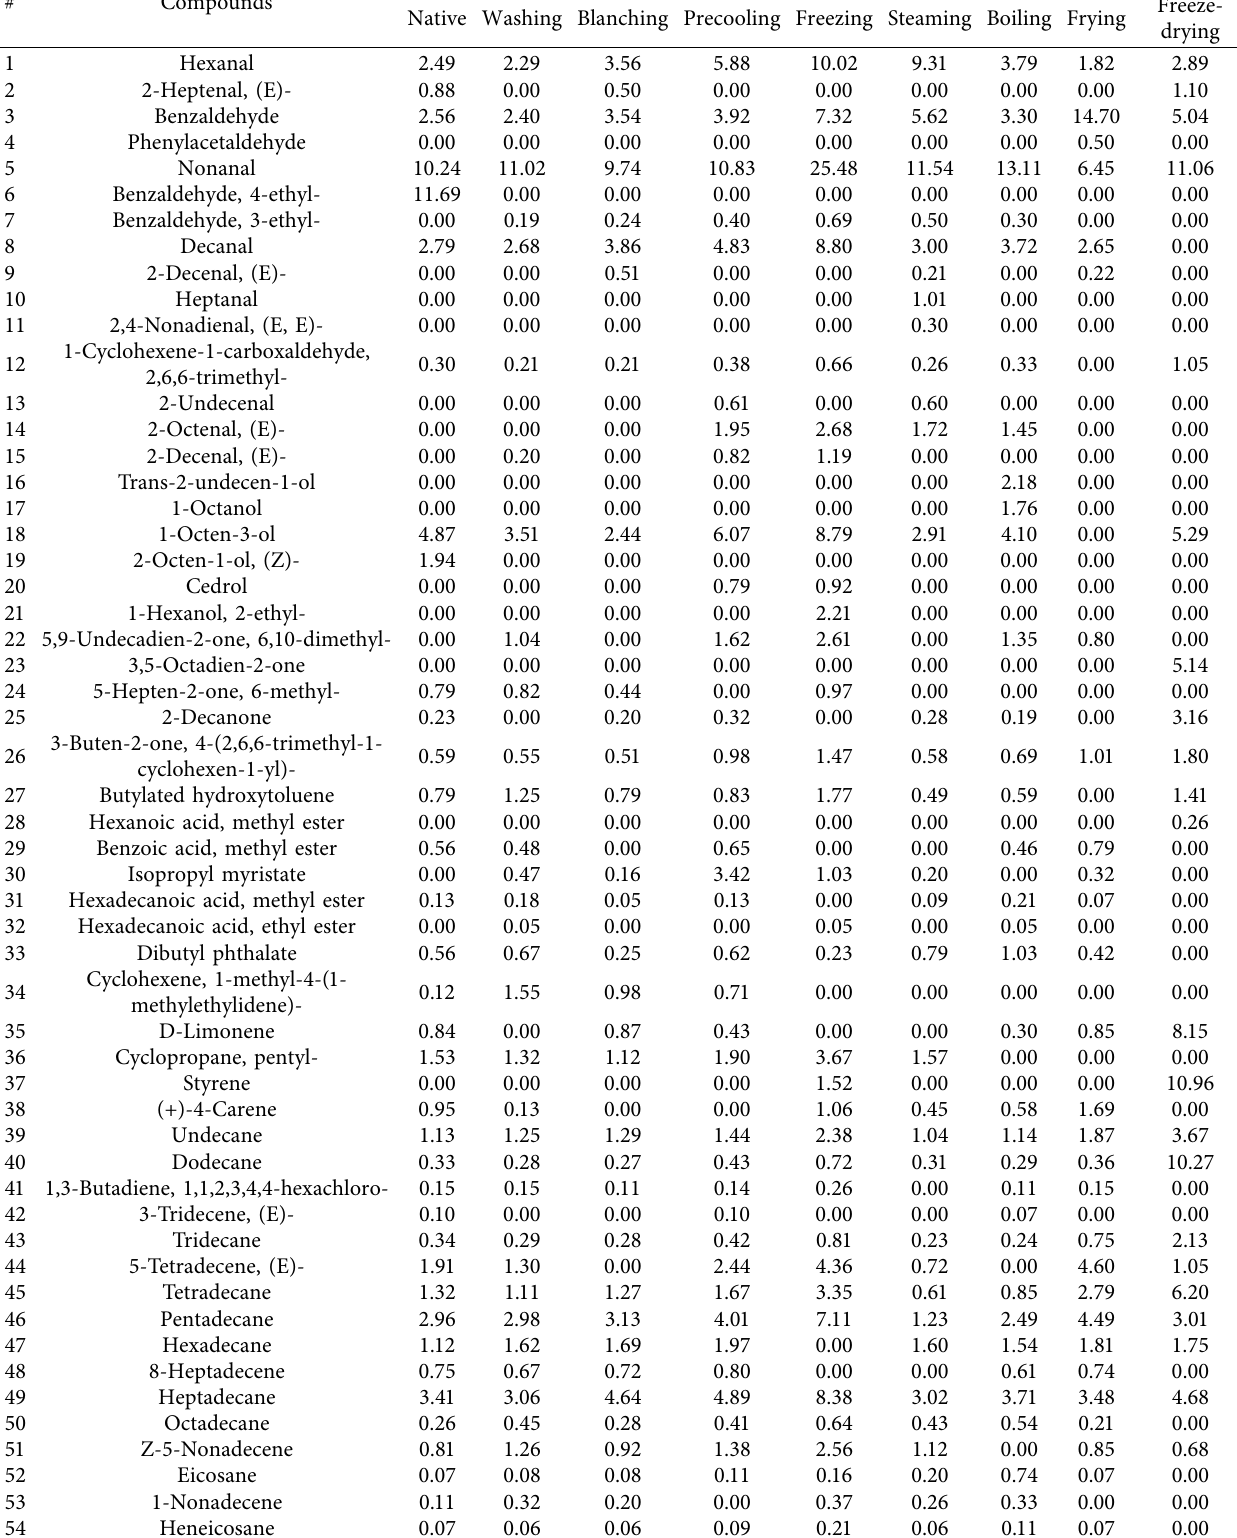
Table 2: GC-MS analysis shows the relative content of main flavor compounds (relative internal standard n -octanol concentration) in different treatment